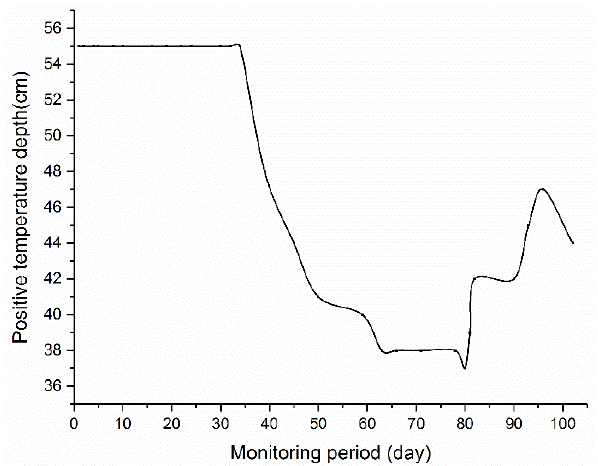
Figure 10. Depth of the positive temperature area at the bottom center of the XPS plates.